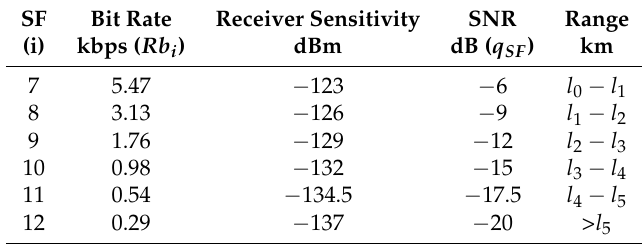
Table 1. Characteristics of the LoRa uplink model containing packets of 9 bytes at BW = 125 kHz. SF Bit Rate Receiver Sensitivity SNR